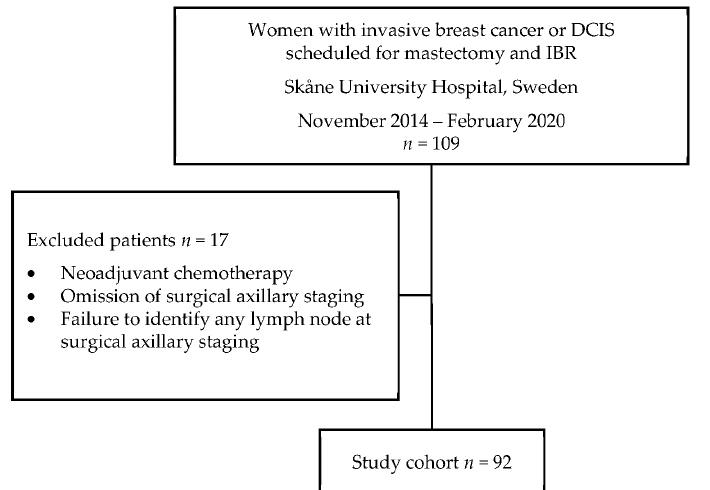
Figure 1. Flow chart of original patient population, excluded patients, and selected study cohort. Abbreviations: DCIS, ductal carcinoma in situ; IBR, immediate breast reconstruction.